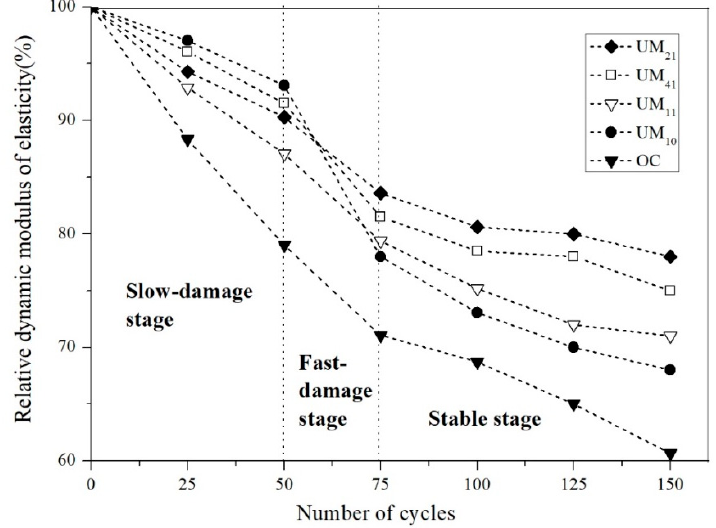
Figure 3. Change in relative dynamic modulus of elasticity (RDMEs) of respective concretes with increasing number of freezing and thawing cycles .